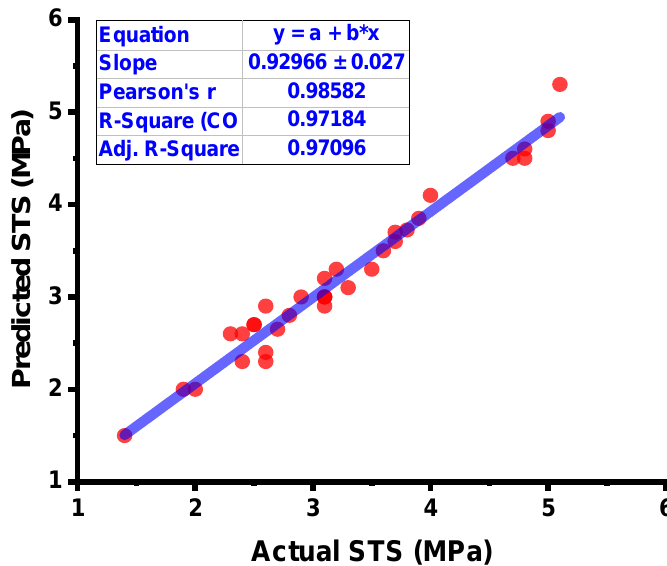
Figure 11. RF model result comparison between the results from laboratory work and predictions.